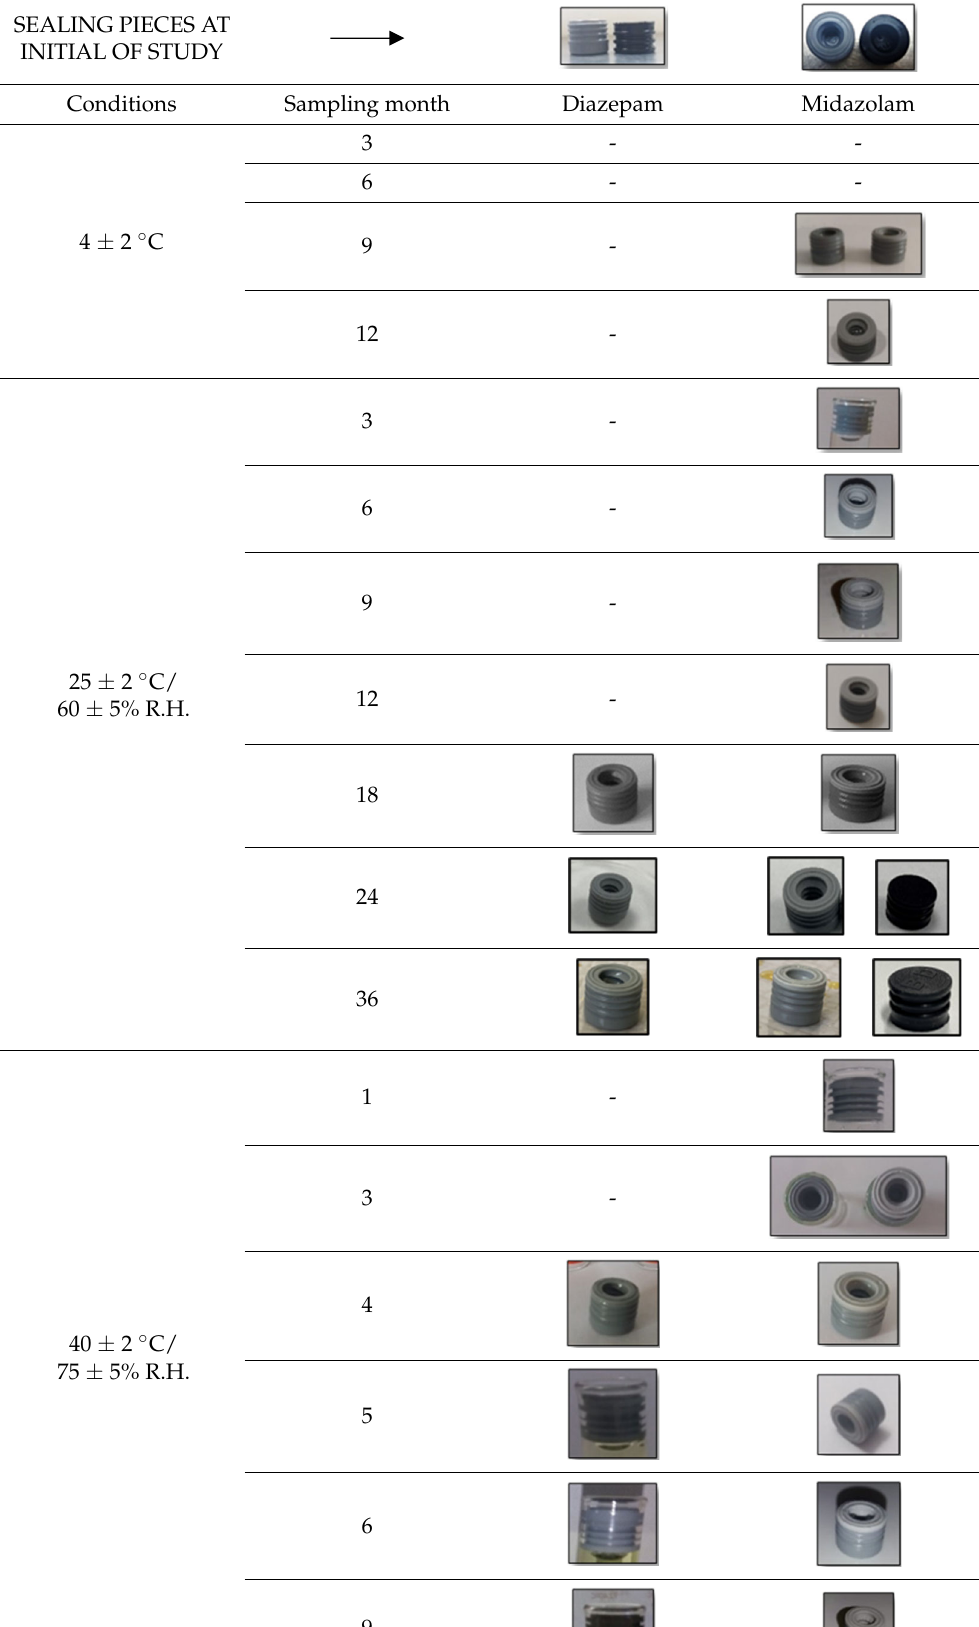
Figure 4. Micrographs obtained with a digital microscope at 200× magnification. Key: ( a ) JEA at time zero; ( b ) JEA after 36 months of exposition to the midazolam solution; ( c ) JEN at time zero; ( d ) JEN after 36 months of exposition to the midazolam solution. Table 4. Visual appearance of the sealing elastomeric gaskets of the syringes in contact with the diazepam and midazolam solutions during the stability test study.